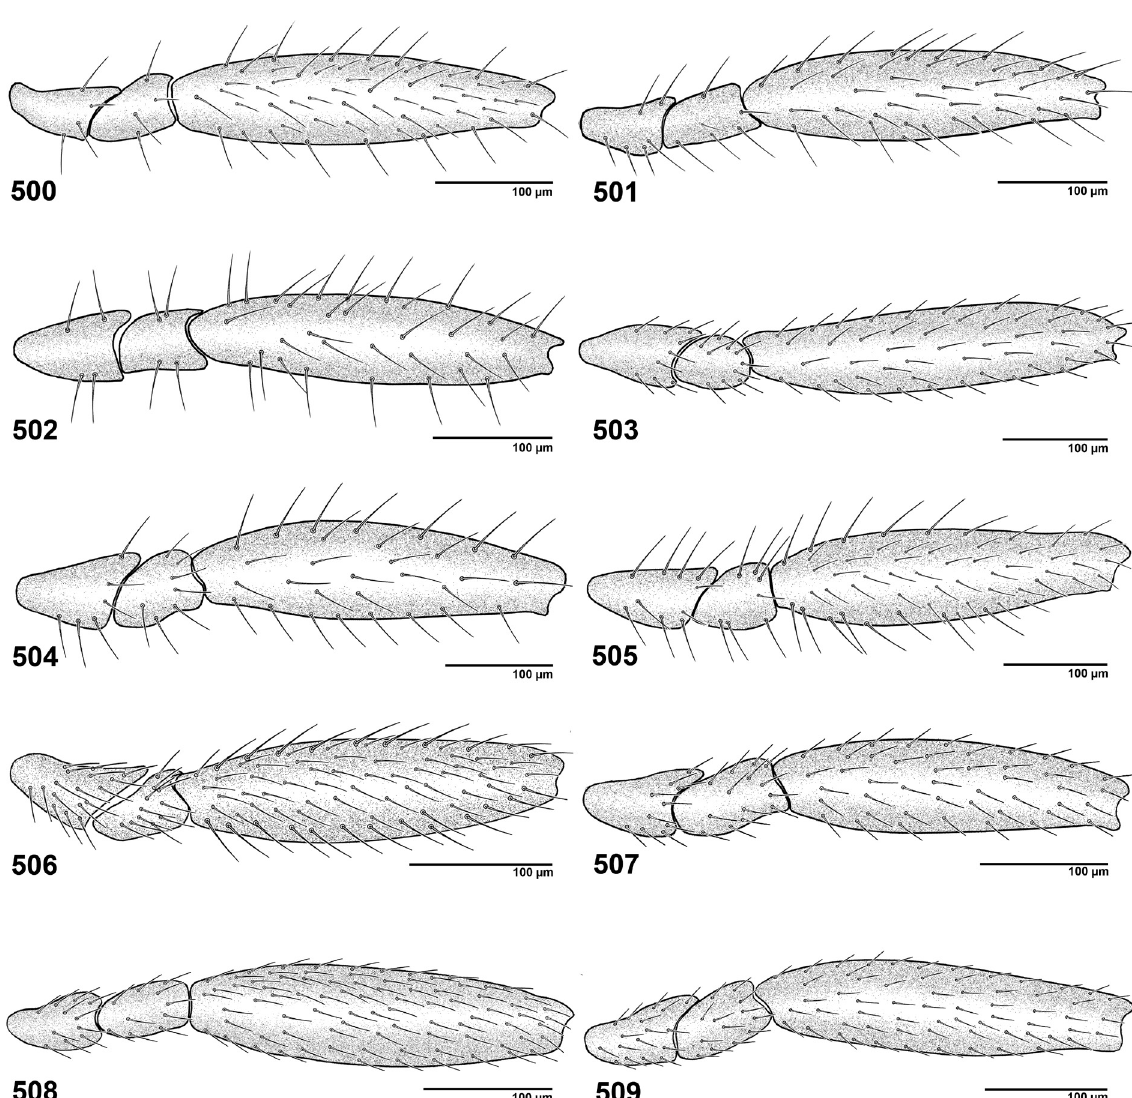
Figs 500–509. Lateral aspect of hind femur in Adialytus and Lysiphlebus species (♀): 500 . Adialytus ambiguus . 501 . Adialytus salicaphis . 502 . Adialytus thelaxis . 503 . Adialytus veronicaecola . 504 . Lysiphlebus cardui . 505 . Lysiphlebus confusus . 506 . Lysiphlebus desertorum . 507 . Lysiphlebus fabarum . 508 . Lysiphlebus fritzmuelleri . 509 . Lysiphlebus testaceipes